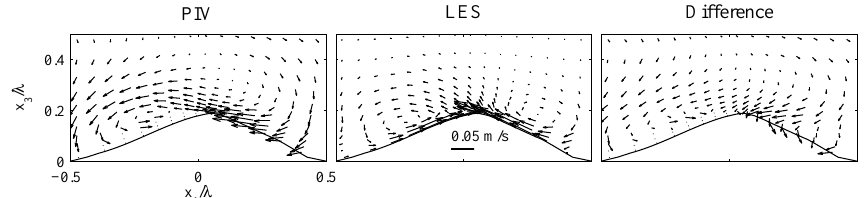
Figure 6. Period- and spanwise-averaged velocity measured in experiments (left panel) and predicted by LES computations, assuming a surface roughness of z 0 = d 50 / 4 (center panel), and the difference between both (right